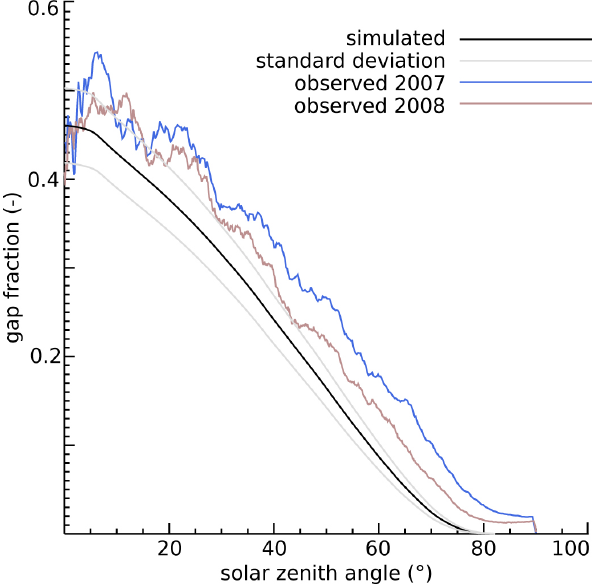
Fig. 3. Gap fraction measured in 2007 and 2008 at the EE-Jär pine forest compared to the modelled gap